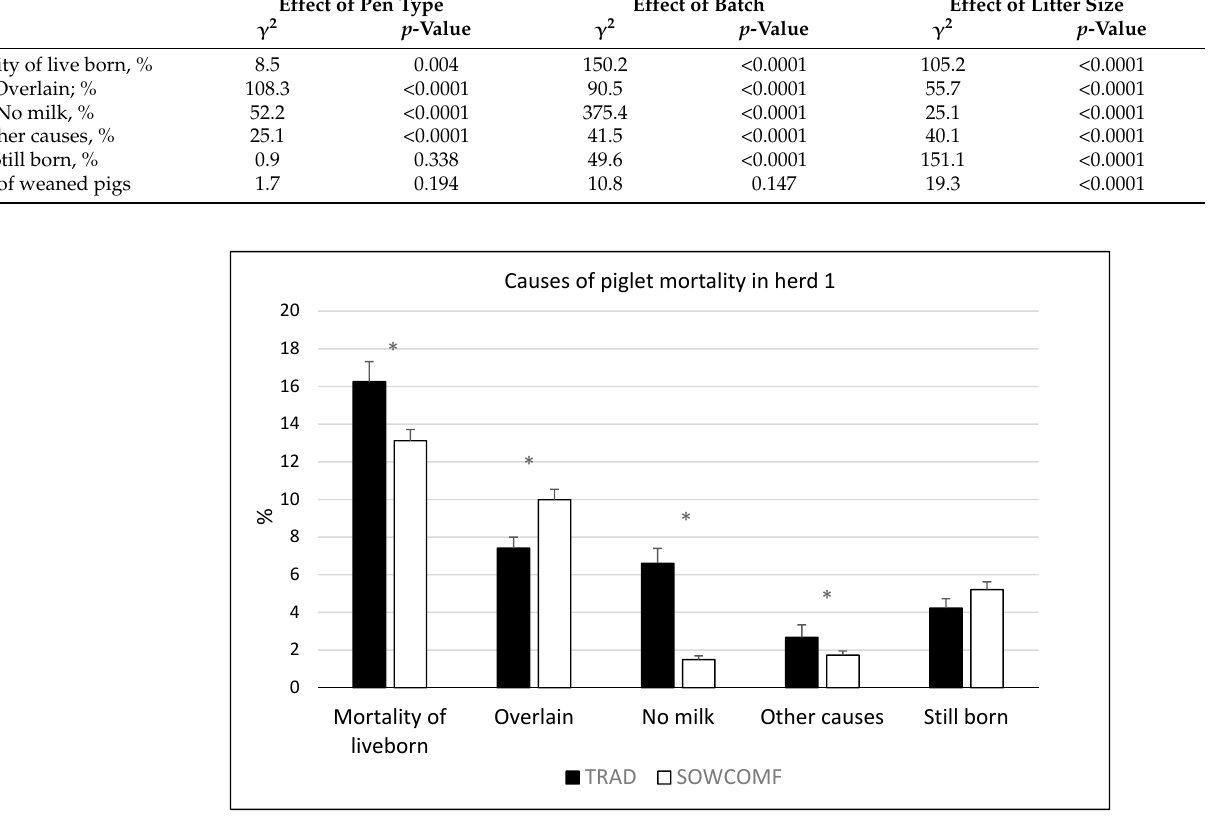
Figure 7. Causes of preweaning mortality (means + SE) in TRAD (Traditional; n = 156 litters) vs. SOWCOMF (SowComfort farrowing pen; n = 343 litters) in the 2nd herd. Except for stillborn which was calculated as % of total born, the other variables were given as % of live born. For each variable, significant differences between the two types of pens (white and black bars) are denoted by different *. Table 4. Production results (means ± SE) from the 2nd herd during the three first batches of TRAD (Traditional: n = 156 litters) followed by seven consecutive batches in SOWCOMF (SowComfort farrowing pen: n = 343 litters). Except for number of liveborn and weaned piglets, the other variables are given in %. Significant differences between each batch within pen type for all variables are de- noted by different superscripts a, b, c, and d.